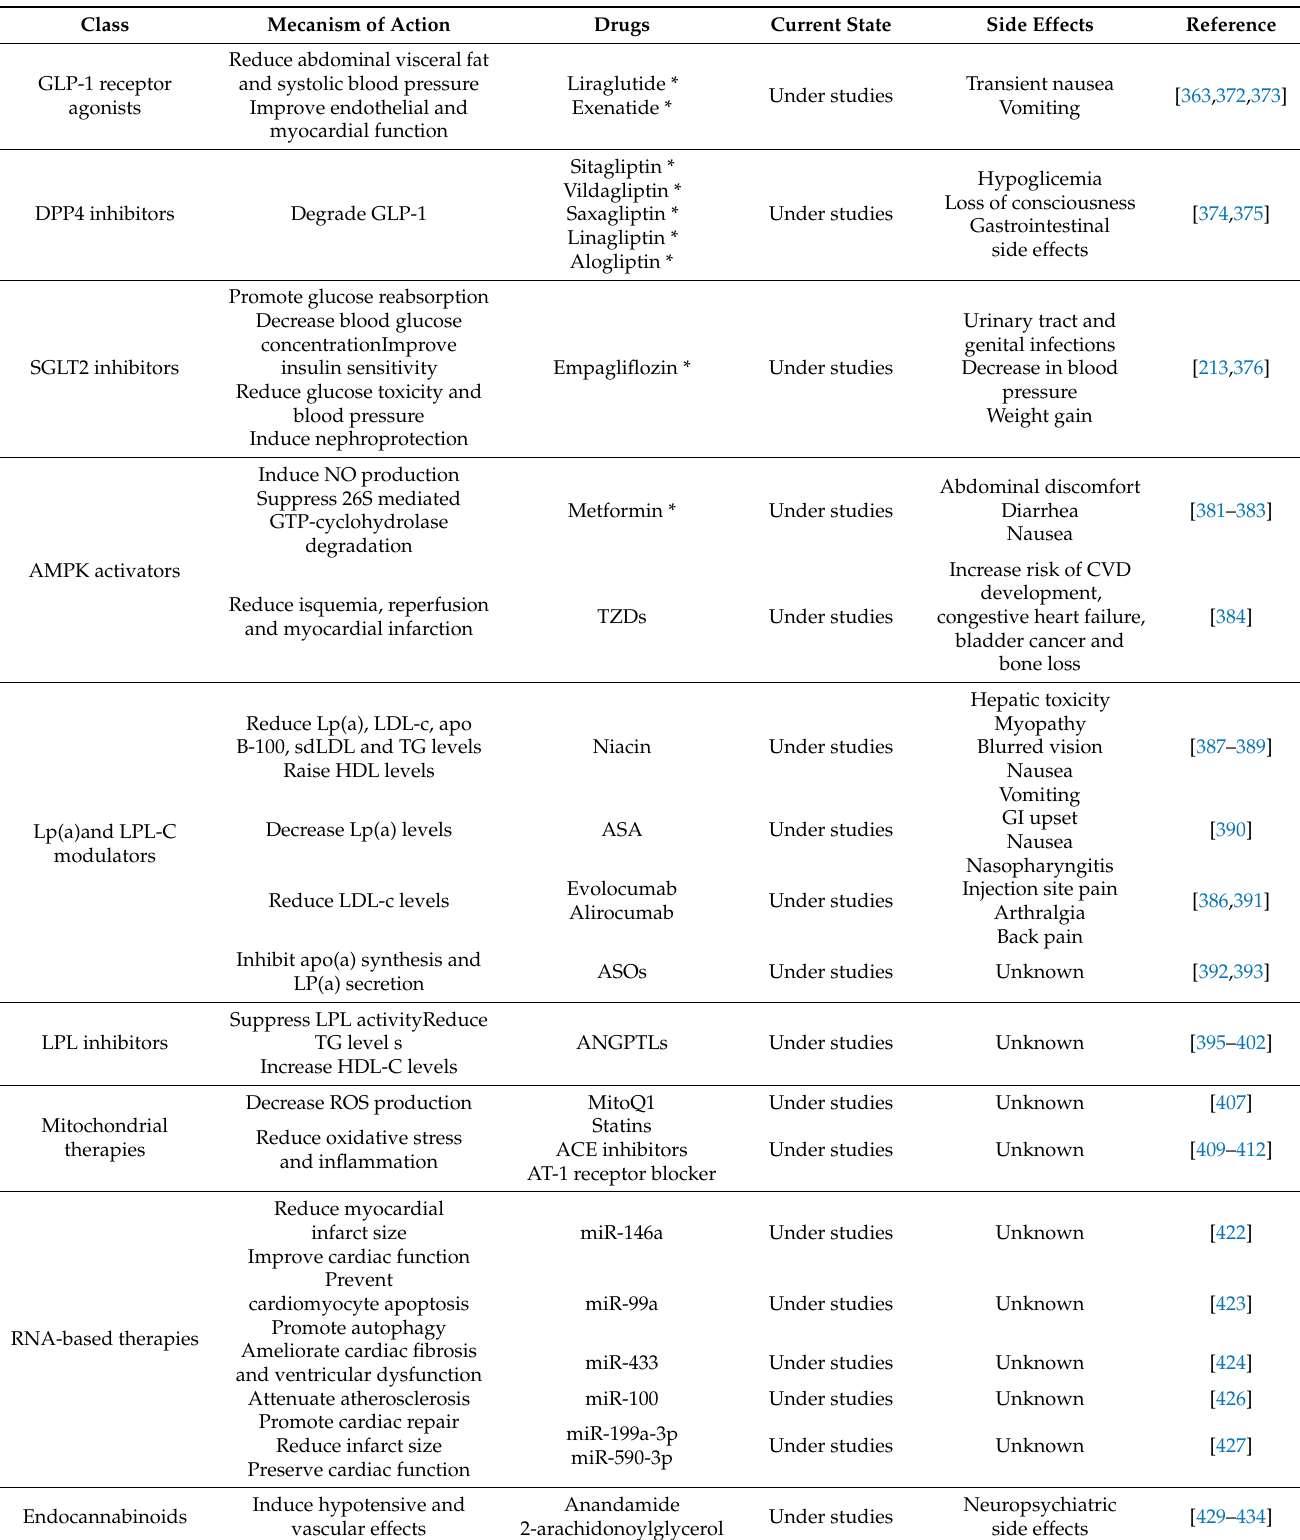
Table 4. Pharmacological treatments for cardiovascular diseases. The compounds are divided into class, mechanism of action, drugs examples, current state of application, and its side